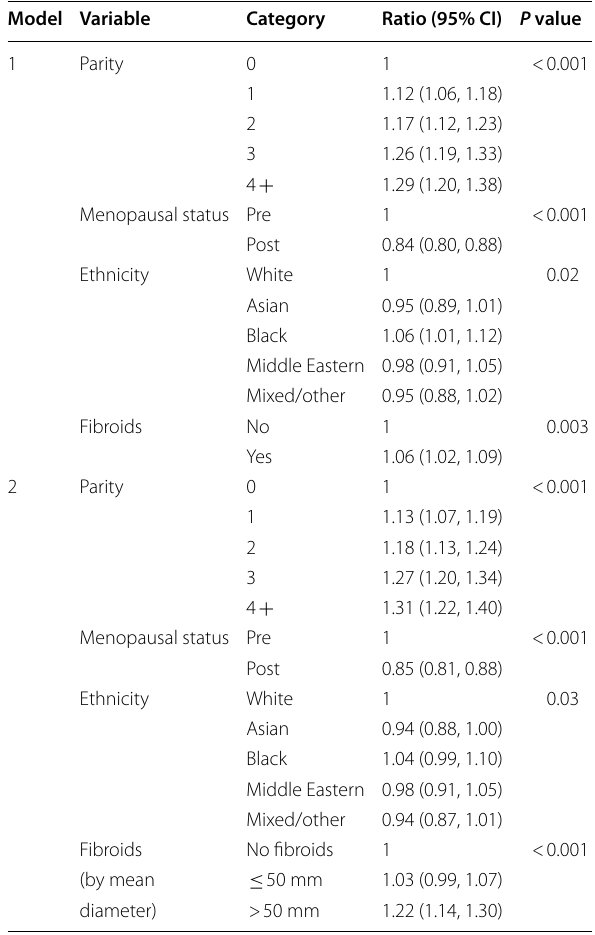
Table 6 Multivariable